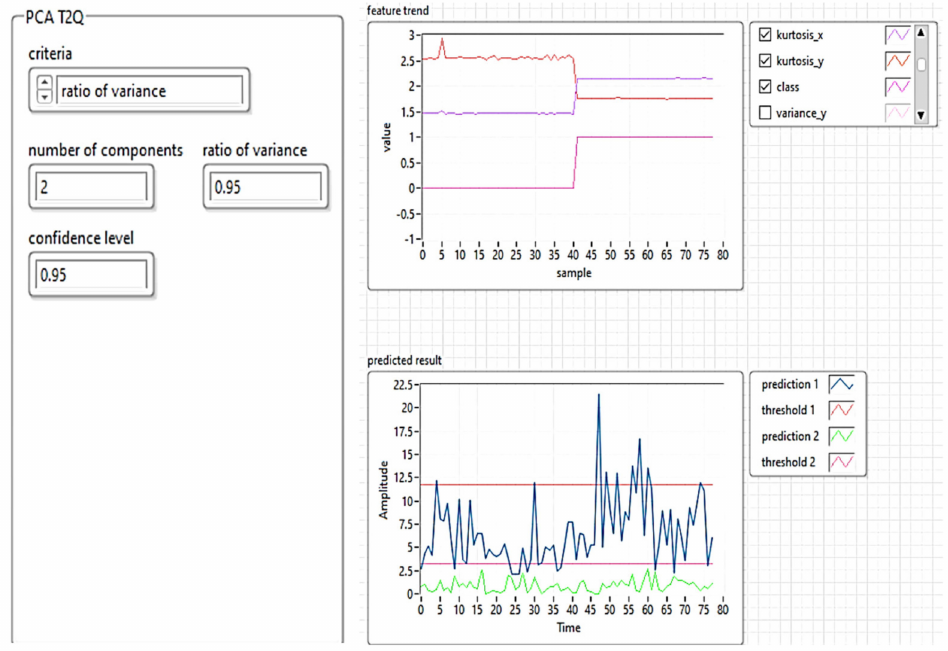
Figure 27. Estimation of rails anomaly detection and predicted result—machine learning modeling using PCA with T 2 Q and ultrasonic